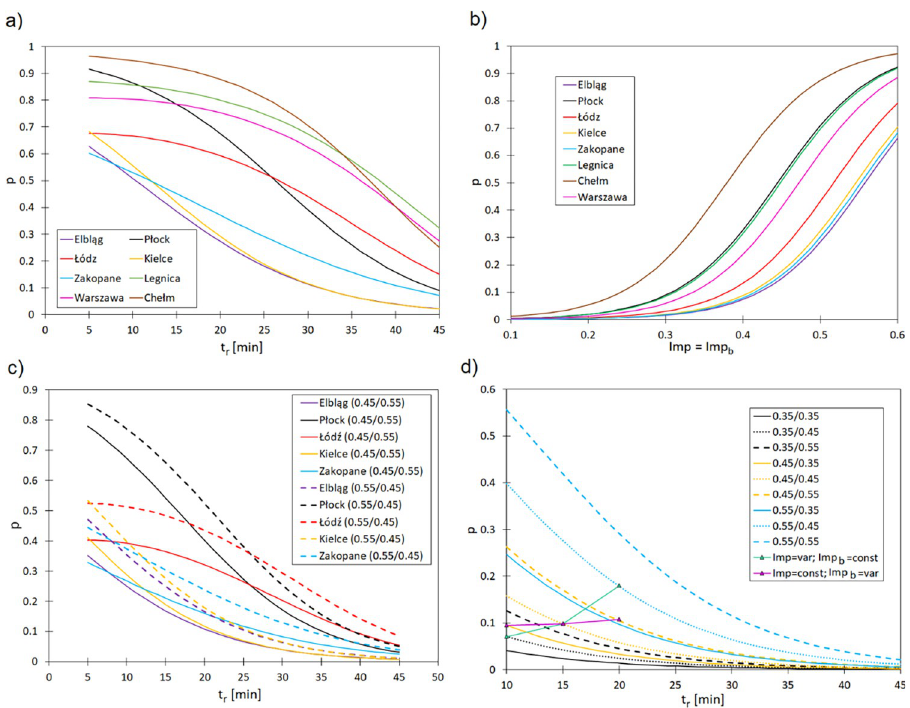
Fig 5. Influence of the convective rainfall event duration on the probability of stormwater flooding. (a) Influence of the convective rainfall event duration on the probability of stormwater flooding in small urban catchments (Imp = Imp b = 0.55) in selected Polish cities. (b) Influence of the Imp = Imp b values for t r = 10 min on the probability of stormwater flooding in the selected Polish cities. (c) Influence of the rainfall duration and spatial distribution of the impervious area on the probability of stormwater flooding in the selected Polish cities. (d) Influence of the spatial distribution of the impervious area in a small catchment on the probability of stormwater flooding on the example of